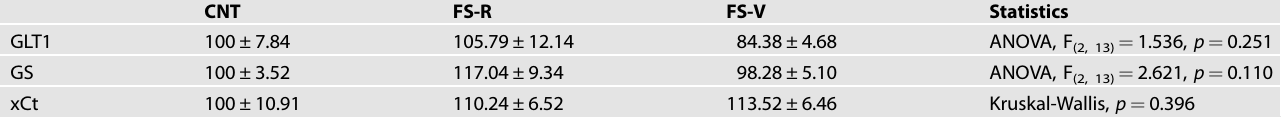
Table 3. Expression of astrocytic proteins related to glutamate homeostasis in PFC homogenates.